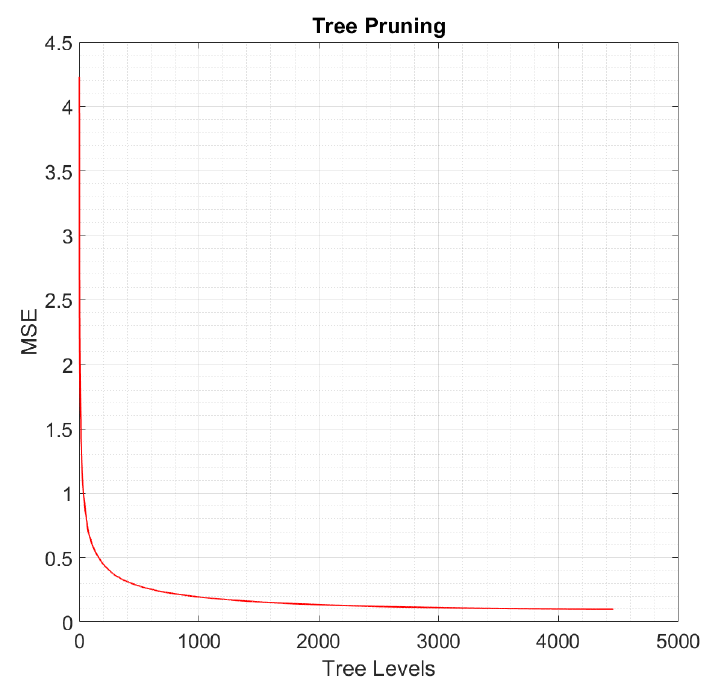
Figure 6. Tree pruning process.